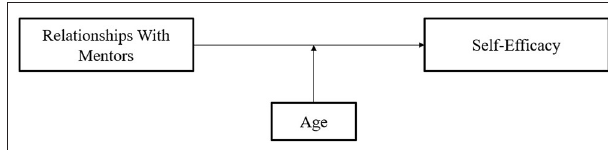
FIGURE 1 | Research framework.